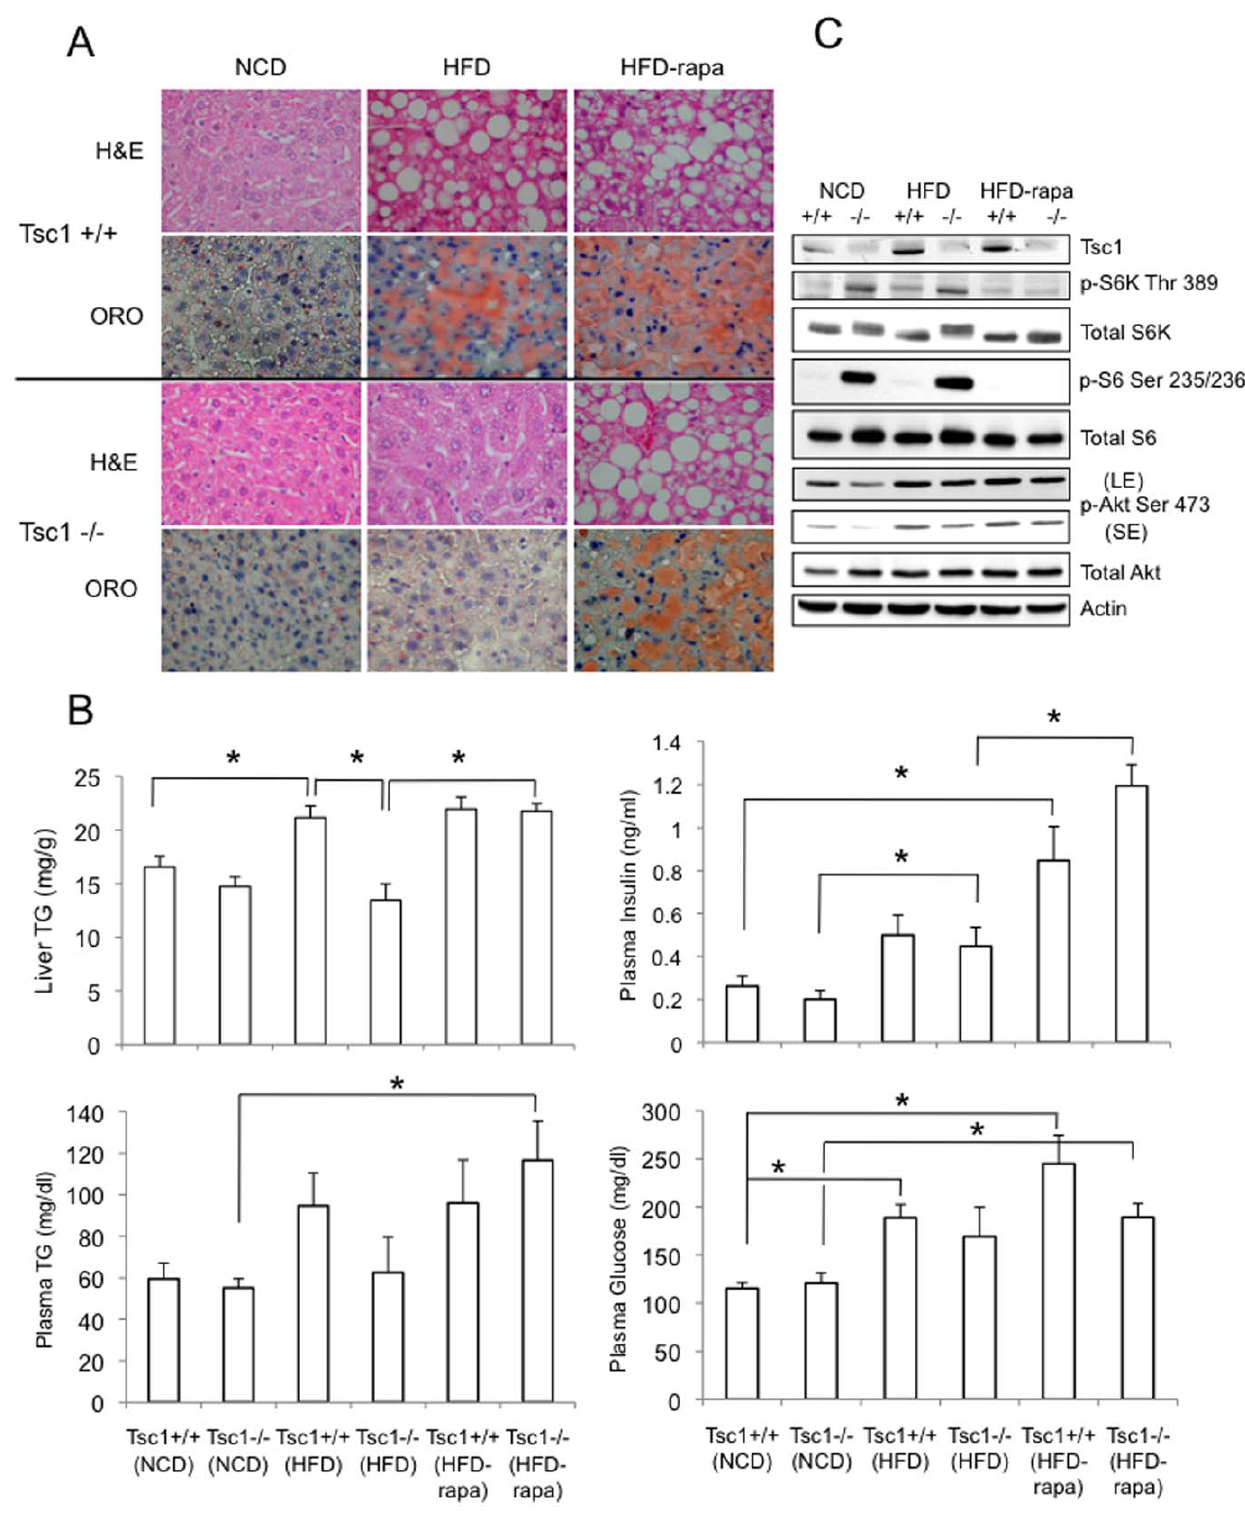
Figure 8. Tsc1 2 / 2 mice are resistant to diet-induced steatosis in a rapamycin-dependent manner. Six week-old Tsc1 + / + and Tsc1 2 / 2 littermates were randomly assigned to normal chow diet (NCD), high fat diet (HFD) or HFD with rapamycin (2 mg/kg IP, 3 times weekly during the last 4 weeks). At the end of 6 weeks on the assigned diets, mice were sacrifice following an overnight fast. A) H&E histology and Oil Red ‘‘O’’ (ORO) staining of representative liver sections from each of the 6 groups. Magnification 400X. B) Biochemical measurements of liver and plasma triglyceride (TG), plasma insulin and glucose levels are shown for each of the groups. Values represent mean 6 SEM. * p , 0.05. C) Western blot analyses of representative liver lysates from each group showing the effects on Akt/mTORC1 signaling. Blots from long exposure (LE) and short exposure (SE) are shown for p-Akt(Ser473). Actin, loading control.